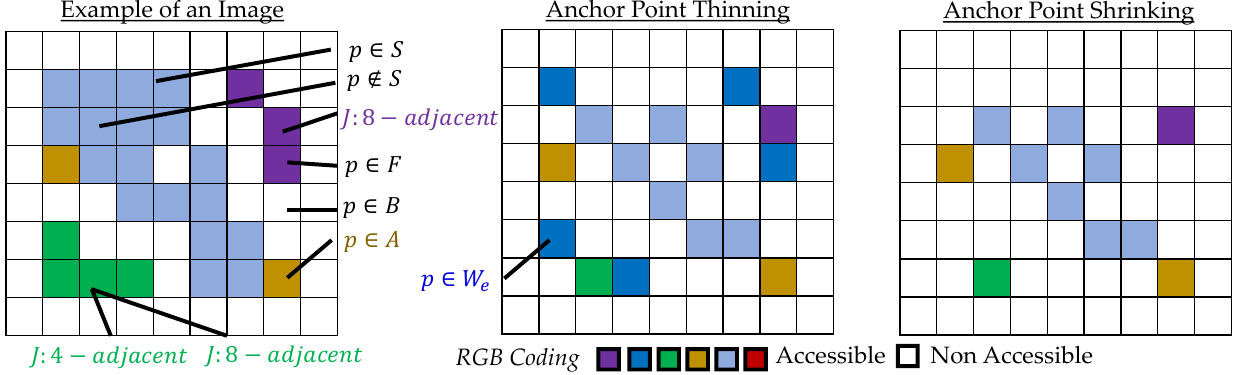
Figure 2. Path generation with shrinking and thinning: image with different regions, erosion due to anchor point thinning, erosion due to anchor point shrinking.